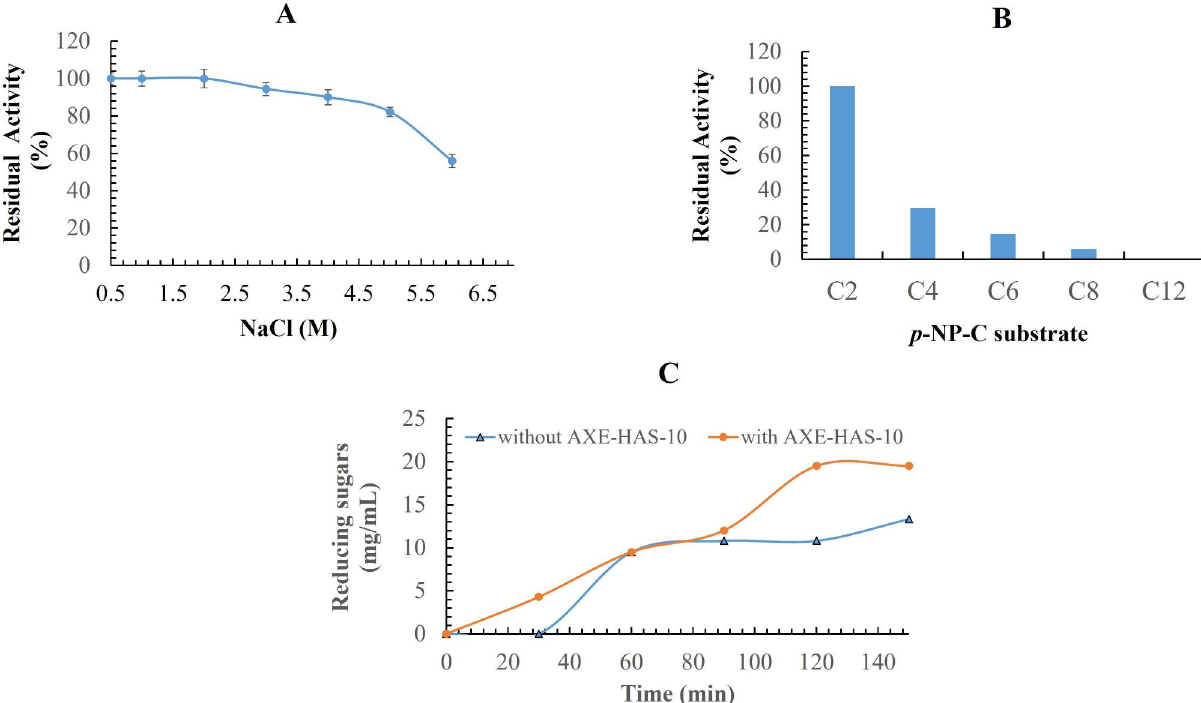
Fig. 6 A: Effect of NaCl on the stability of purified to homogeneity AXE-HAS10 after pre-incubation of the purified AXE-HAS10 with effector for 30 min. Values are the mean of three readings ± standard error. B: Substrate specificity determination of AXE-HAS10 using p -nitrophenyl esters of different chain lengths: ( p -nitrophenyl acetate ( p -NP-C2,), p -nitrophenyl butyrate ( p -NP-C4), p -nitrophenyl caproate ( p -NP-C6), p -nitrophenyl caprylate ( p -NP-C8), and p - nitrophenyl laurate ( p- NP-C12)). Values are the mean of three readings ± standard error. C: Synergistic effect of AXE-HAS10 on beechwood xylan hydrolysis mediated by partially purified xylanase of P. chrysogenum Strain A3 DSM105774. Values are the mean of three readings ± standard